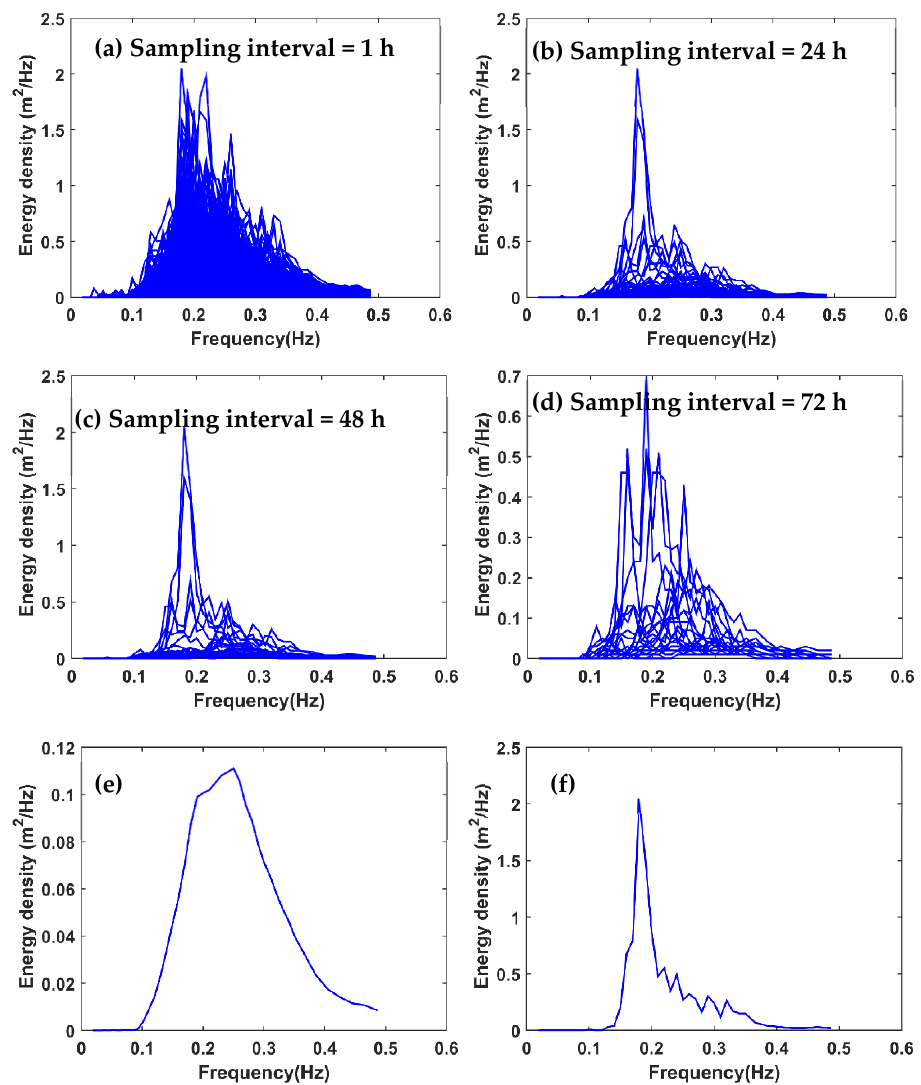
Figure 10. Accumulative plots of measured frequency spectra at NDBC 42040 with different sampling intervals between July and August 2015, ( a ) sampling interval = 1 h, ( b ) sampling interval = 24 h, ( c ) sampling interval = 48 h, ( d ) sampling interval = 72 h, ( e ) average spectrum between July and August 2015, ( f ) the spectrum corresponding to the maximum spectral energy peak during this pe- riod.